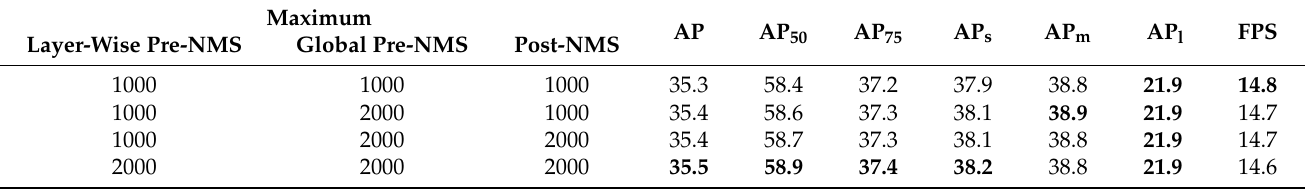
Table A2. Comparing impact of maximum number of detections before and after NMS processing on accuracy and inference time. The number of detections is limited per neck layer before the NMS, after concatenating detections from all neck layers but before applying NMS and after applying NMS. While increasing the maximum number of detections increases the precision, it impairs the performance in similar ratio and does not provide a benefit in terms of